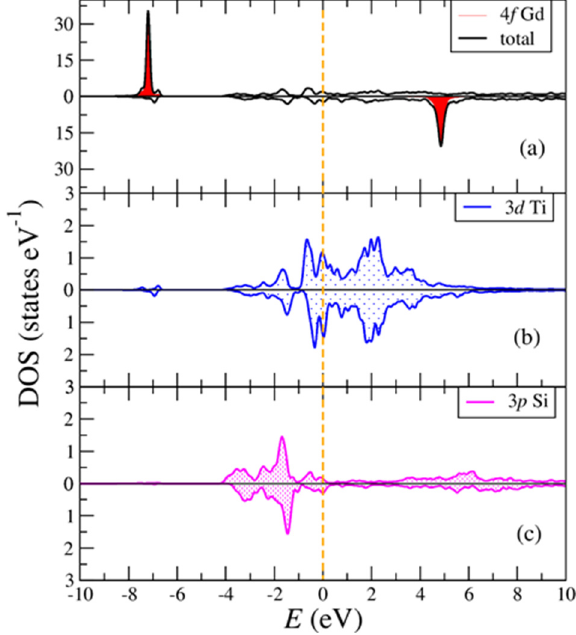
Figure 5. The density of states of GdTiSi per formula unit. ( a ) Total and partial Gd-4f densities of states; ( b ) partial density of states for Ti-3d; ( c ) partial density of states for Si-3p. The Fermi level is a dashed vertical line.